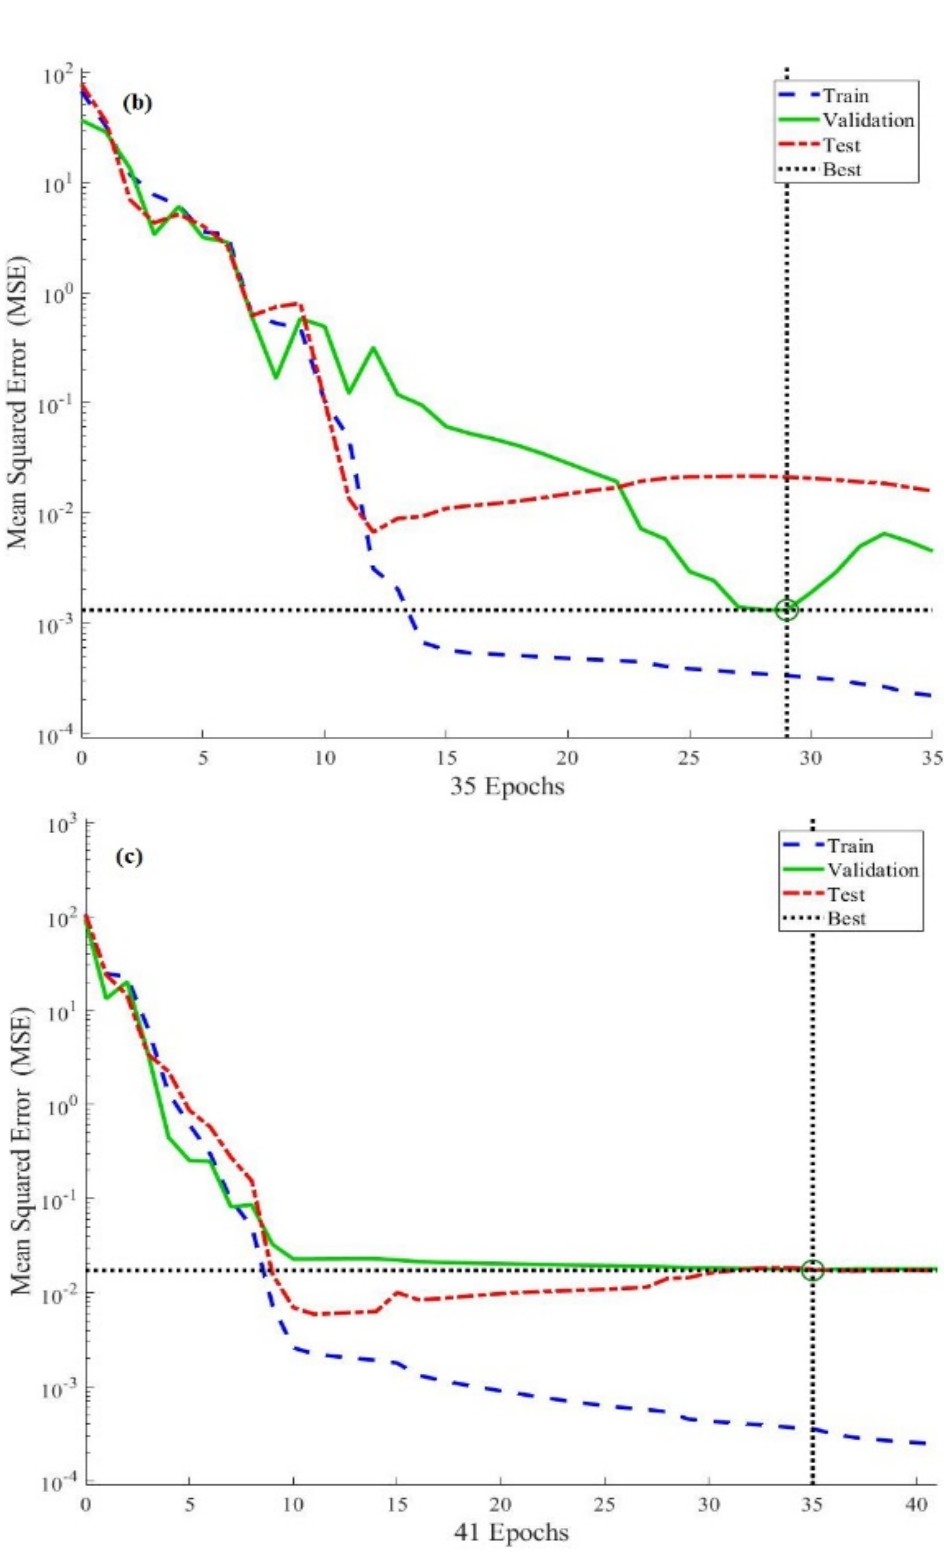
Figure 2. ( a ) Training performance of ANN model-I. ( b ) Training performance of ANN model-II. ( c ) Training performance of ANN model-III.